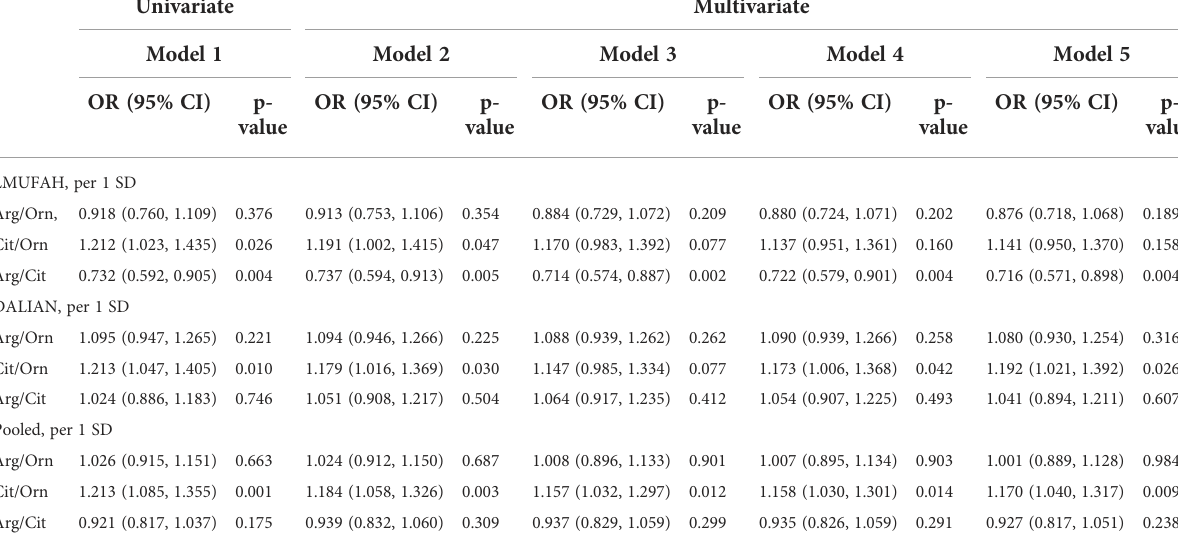
TABLE 3 Ratios of amino acids related to the urea cycle for the risk of diabetic nephropathy.